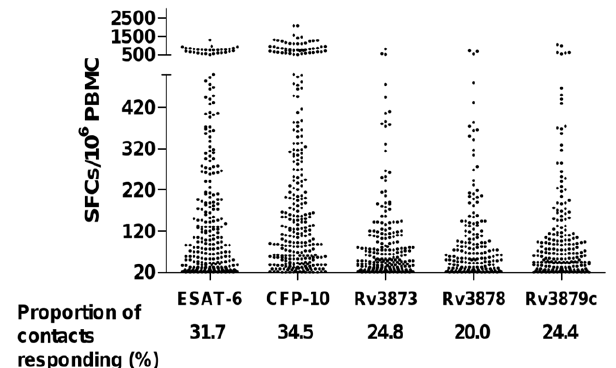
Figure 2. Magnitude of IFN- c T-cell responses to each RD1- encoded antigen among responders to each antigen. The median (inter-quartile range) of antigen-specific T-cells in individuals who had a positive ELISpot response to ESAT-6, CFP-10, Rv3873, Rv3878 and Rv3879c were: 104 (38, 274.5), 133 (55.5, 348.5), 52 (30.5, 110), 62 (30, 124) and 64 (32, 115.5) per million PBMCs respectively. Significantly more contacts had T-cell responses to CFP-10 (P , 0.001) and ESAT-6 (P , 0.002) than to any of the novel antigens. Fewer contacts mounted a T-cell response to Rv3878 than any other antigen (P , 0.001 in all cases) and the proportion of contacts with T-cell responses to Rv3873 and Rv3879c did not significantly differ from each other. CFP-10 responses were significantly greater than responses to any other antigen (P ,